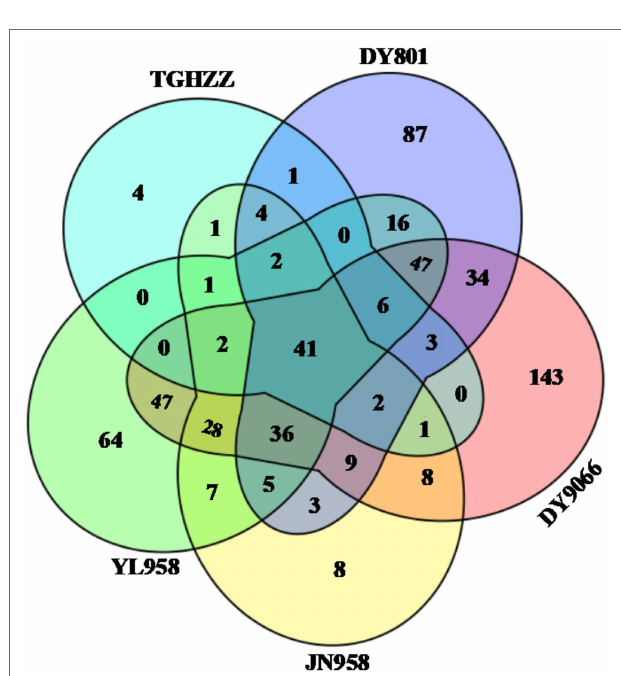
FIGURE 3 | Venn diagram showing the number of unique and shared OTUs in the gut of all Helicoverpa armigera caterpillars from the five populations. OTUs shared by all individuals in each of five populations were selected for each population, and then the numbers of unique and shared OTUs among the five populations were